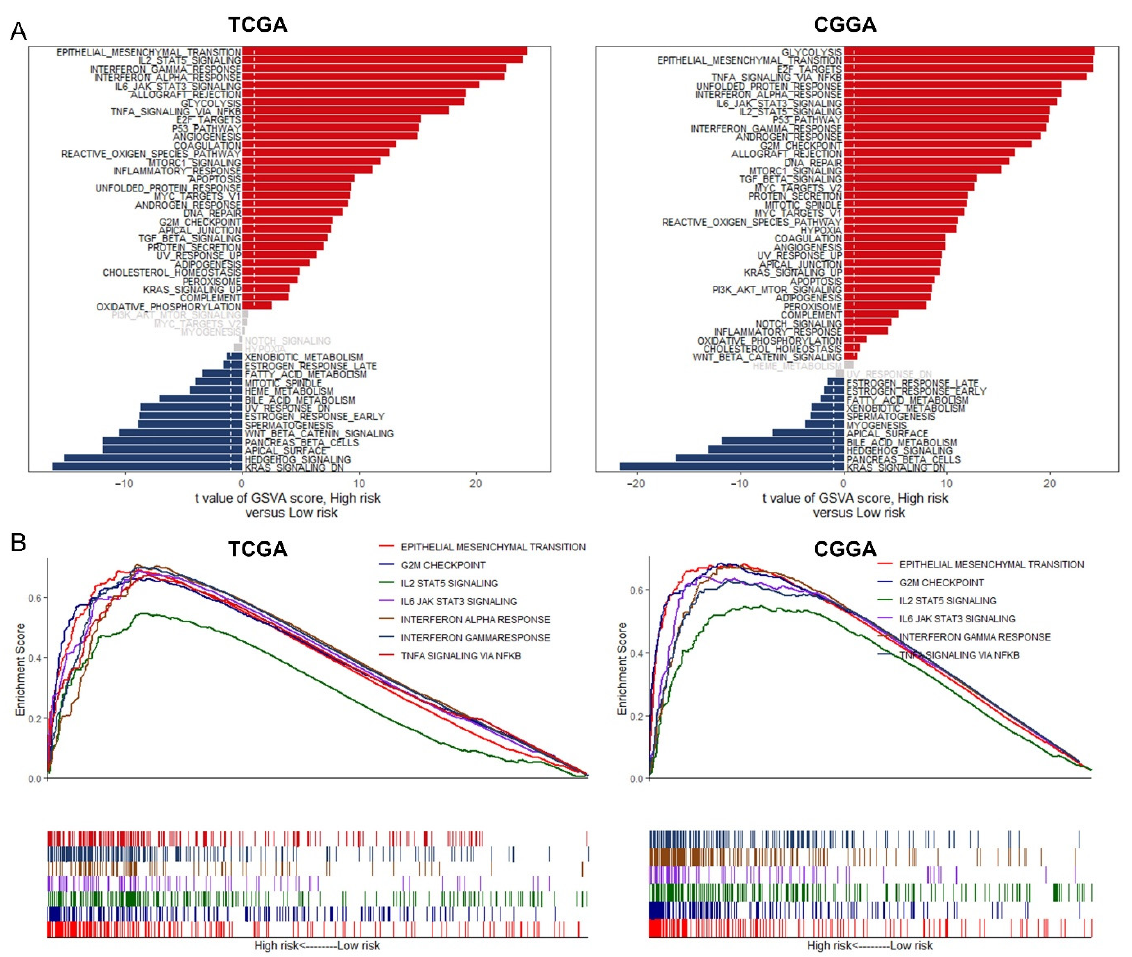
Figure 8. The GSVA and the GSEA for different risk groups: ( A ) The enrichment of GSVA between the low- and high-risk group and the significantly differentially expression pathways validated by “limma” analysis. ( B ) GSEA plot of major gene sets coactivated in both TCGA and CGGA. Table 1. Univariate and multivariate Cox regression analysis of clinical pathologic features in TCGA database.